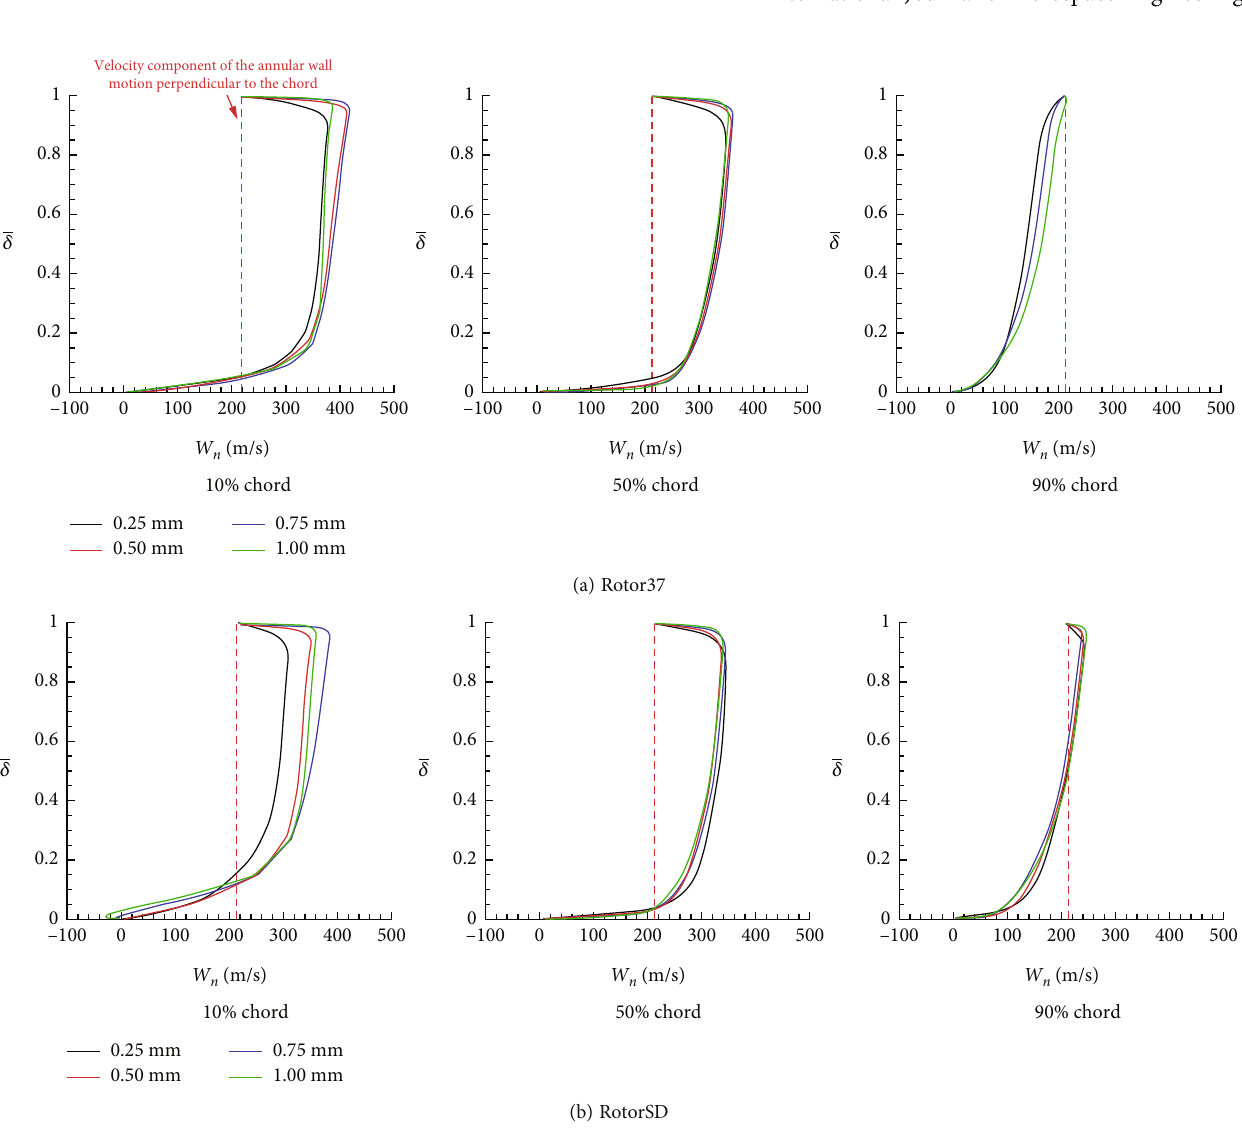
Figure 28: Distribution of the normal velocity along the gap height at 10%, 50%, and 90% chord